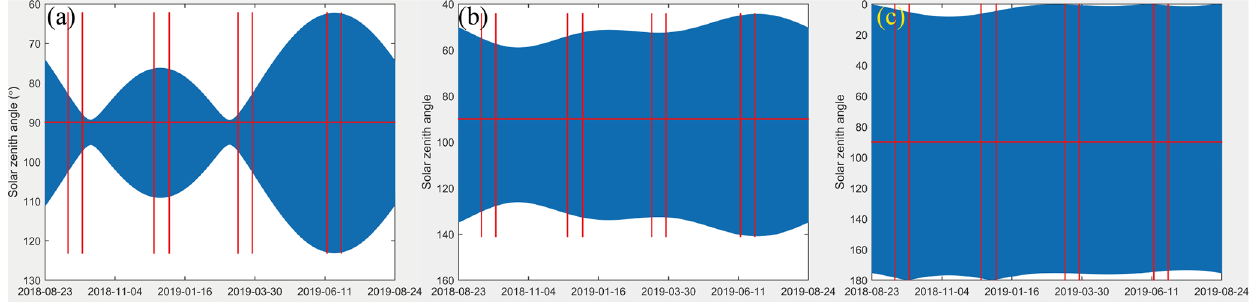
Figure 2. The variations in solar zenith angles of the off-nadir points on the three orbits within 1 year. The four time ranges divided by eight red lines denote 15d near the autumn equinox, winter solstice, spring equinox, and summer solstice, respectively. Sun-synchronous orbits with LTANs of 18:00 (a) , 15:00 (b) , and 12:00LT (c)